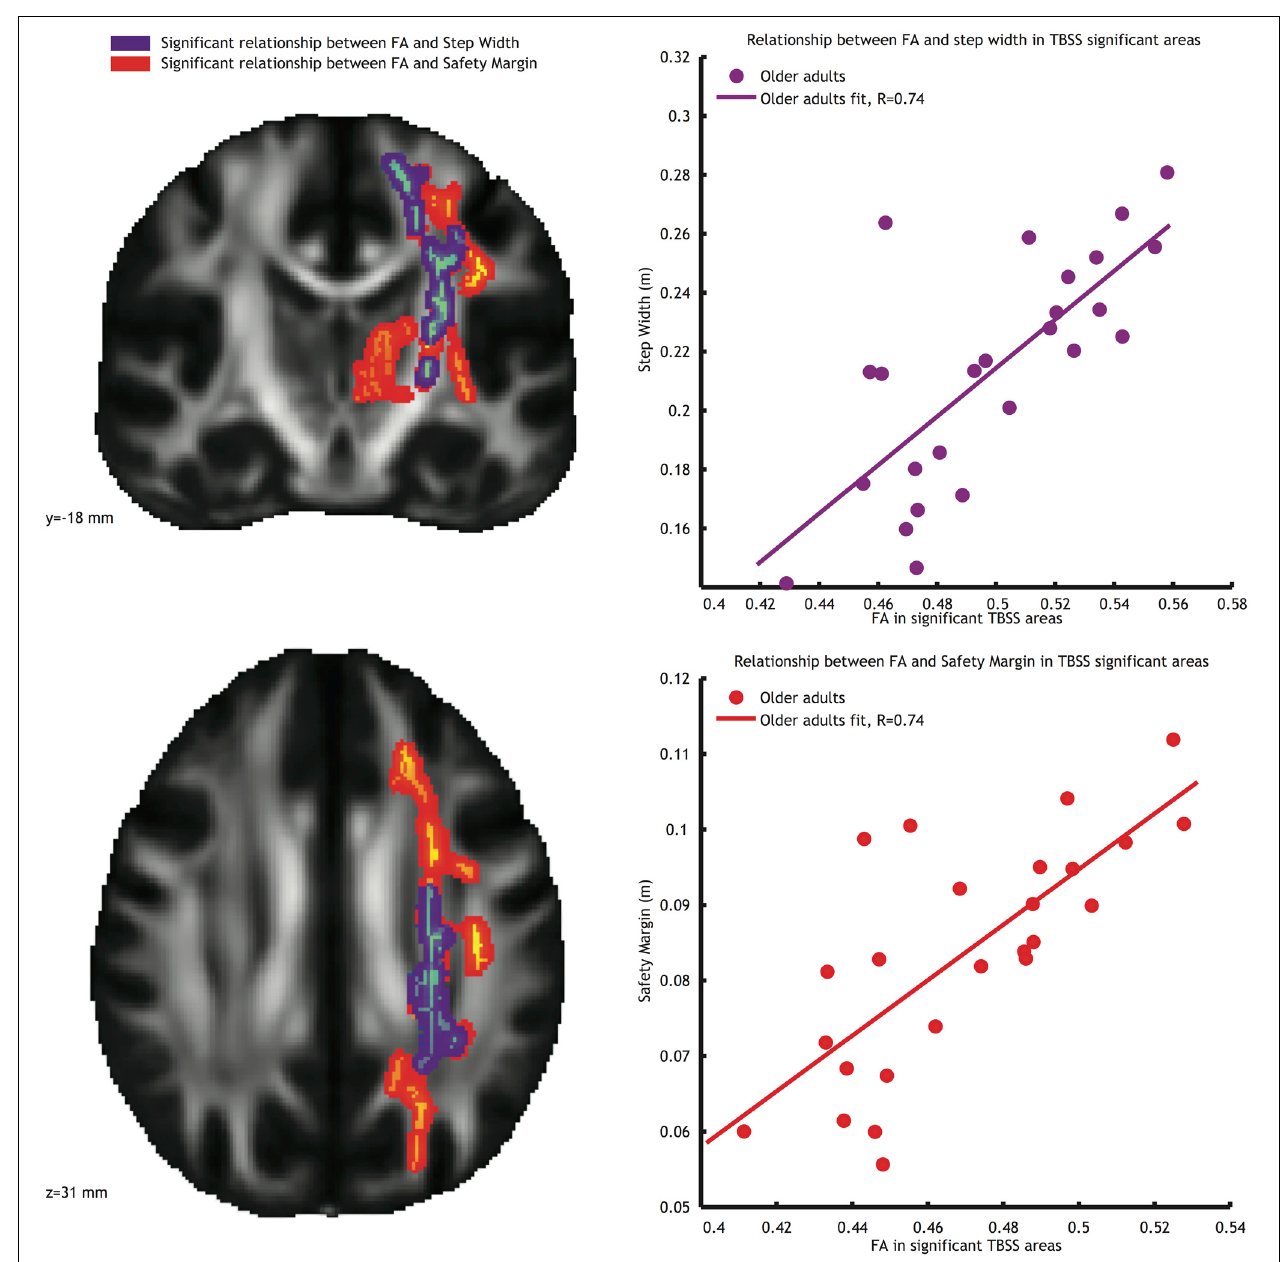
FIGURE 3 | Left panels : Voxels showing significant correlations ( P < 0 . 05, TFCE corrected) between FA and step width (blue-purple) and FA and safety margin (red) in the older adults group. Right panels : Correlations between